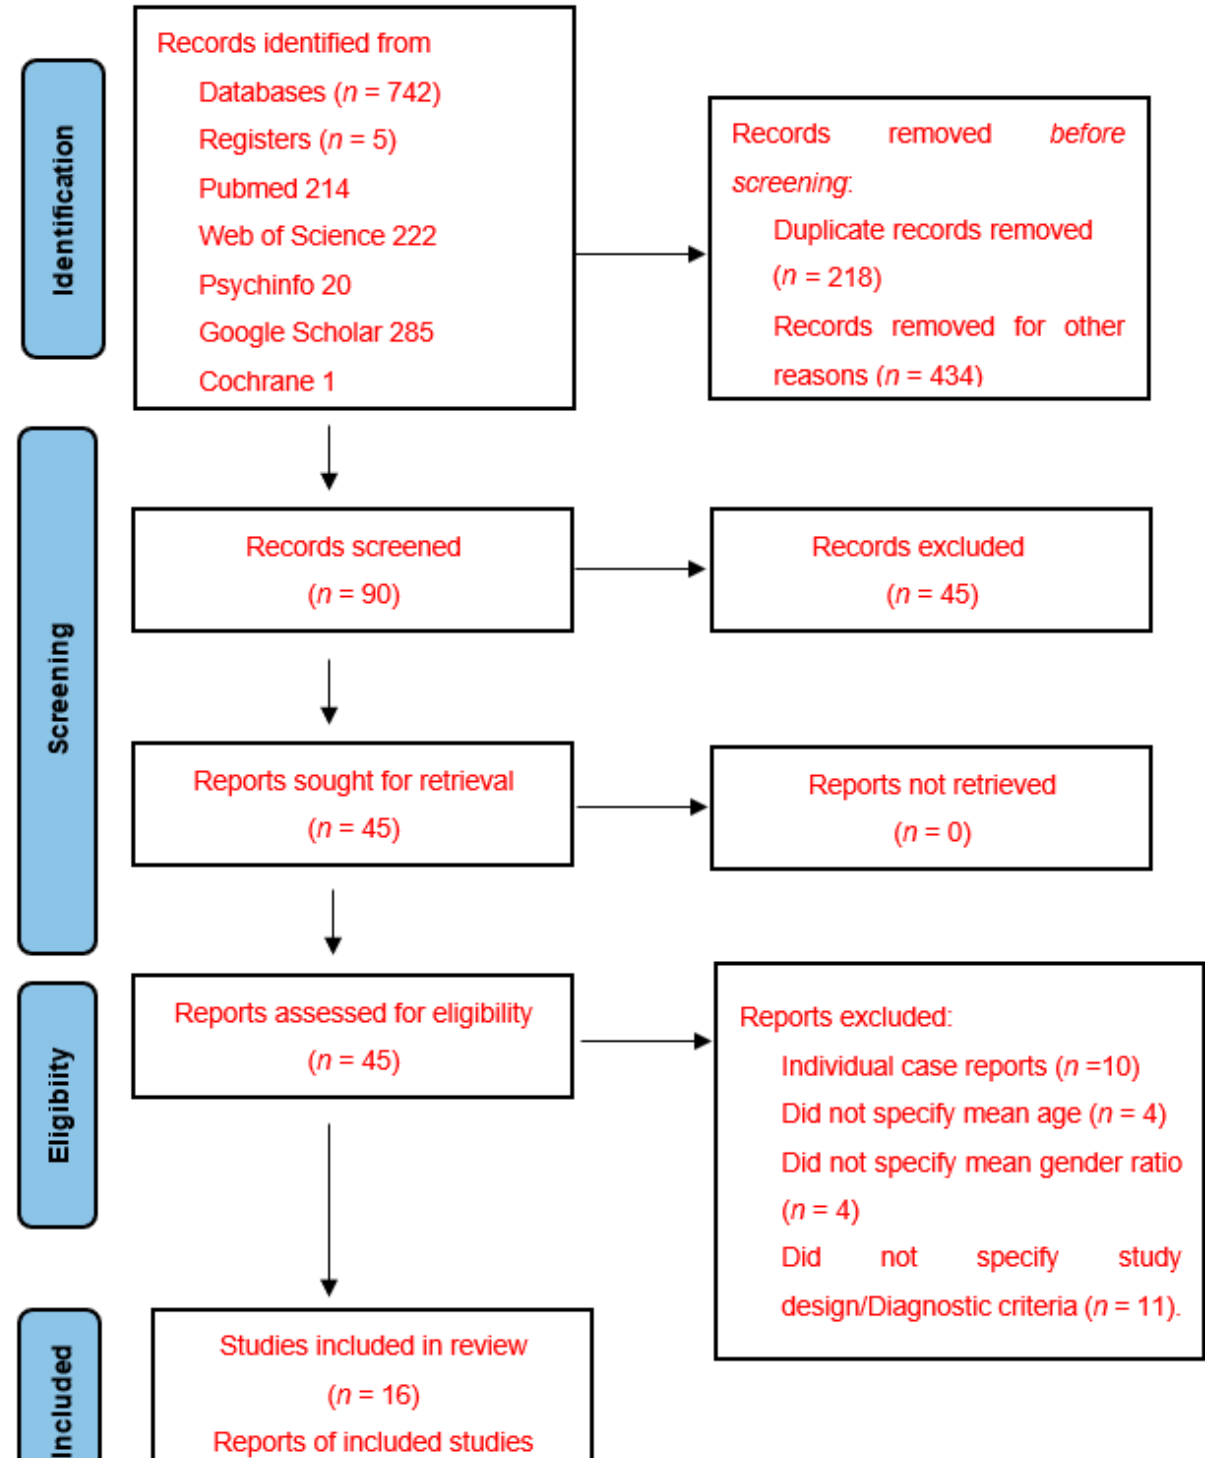
Figure 1. PRISMA flow chart of the screened and included studies.